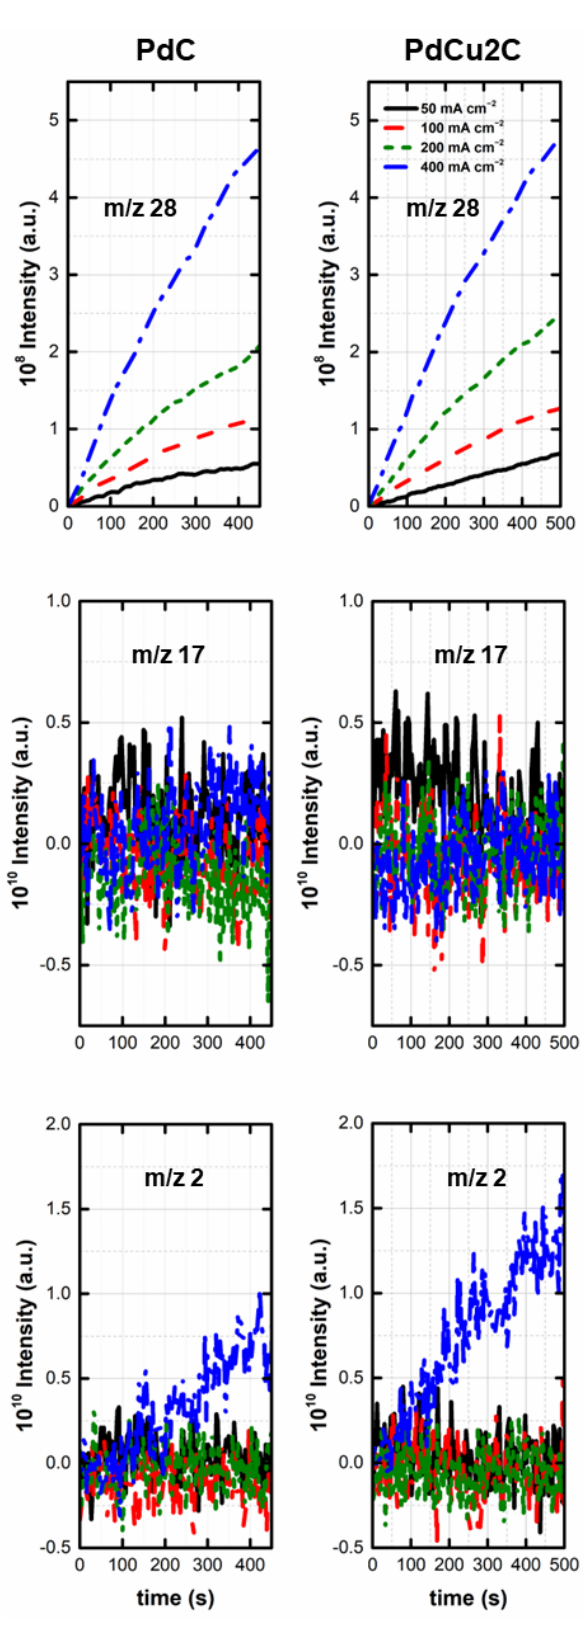
Figure 6. Mass spectra of the anode exhaust for N 2 ( m / z = 28), NH 3 ( m / z = 17) and H 2 ( m / z = 2) for different current densities (first column corresponds to PdC and the second column to PdCu2C).